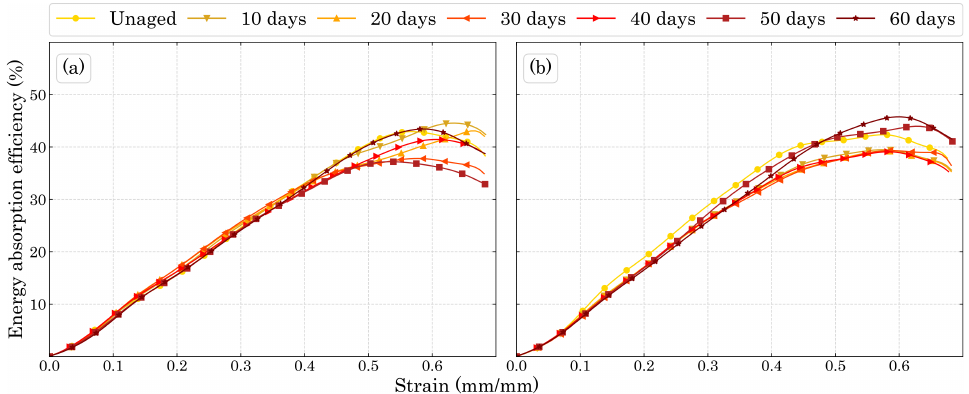
Figure 10. Energy absorption efficiency for ( a ) Dir3 and ( b ) Dir1.